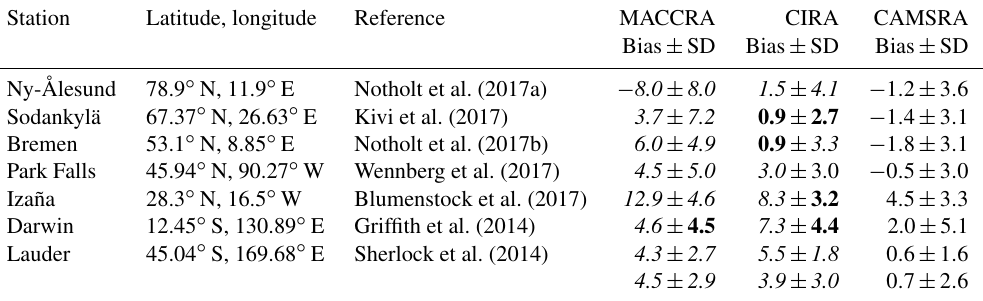
Table 5. TCCON stations used in this paper and mean biases and standard deviations from MACCRA, CIRA and CAMSRA (shown in Fig. 13; in ppb). The values for CIRA and CAMSRA are calculated for the period 2003–2016, and the values for MACCRA are calculated for the period 2003–2012. Numbers in italics mark where MACCRA or CIRA have larger biases or standard deviation than CAMSRA, and numbers in bold mark where their values are